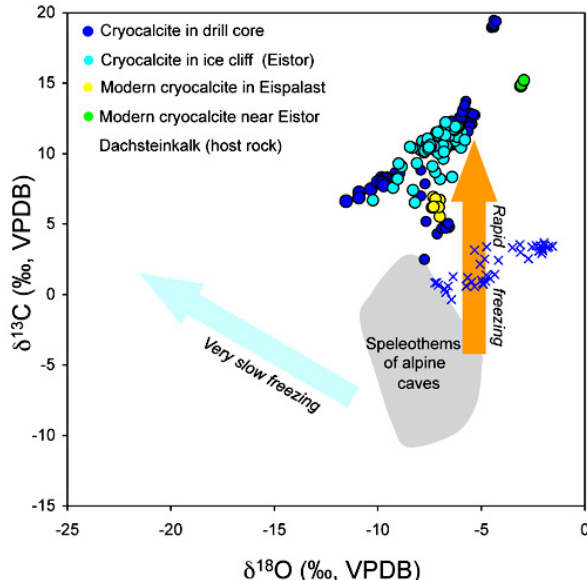
Fig. 5. Stable istopic composition of calcite extracted from “dust layers” in the drilled ice core in comparison to samples previously analyzed from similar layers in the well-stratified ice at the nearby Eistor (Sp¨otl, 2008) and modern samples of cryogenic calcite silt collected on the ice surface in spring of 2008. The arrows indicate two evolutionary pathways observed in studies of cryogenic calcite precipitates. Note the high C isotope values of Eisriesenwelt cry- ocalcite as compared to (a) values of typical dripstones (stalagmites, flowstones) from caves in the Alps and (b) samples of the host rock in which Eisriesenwelt